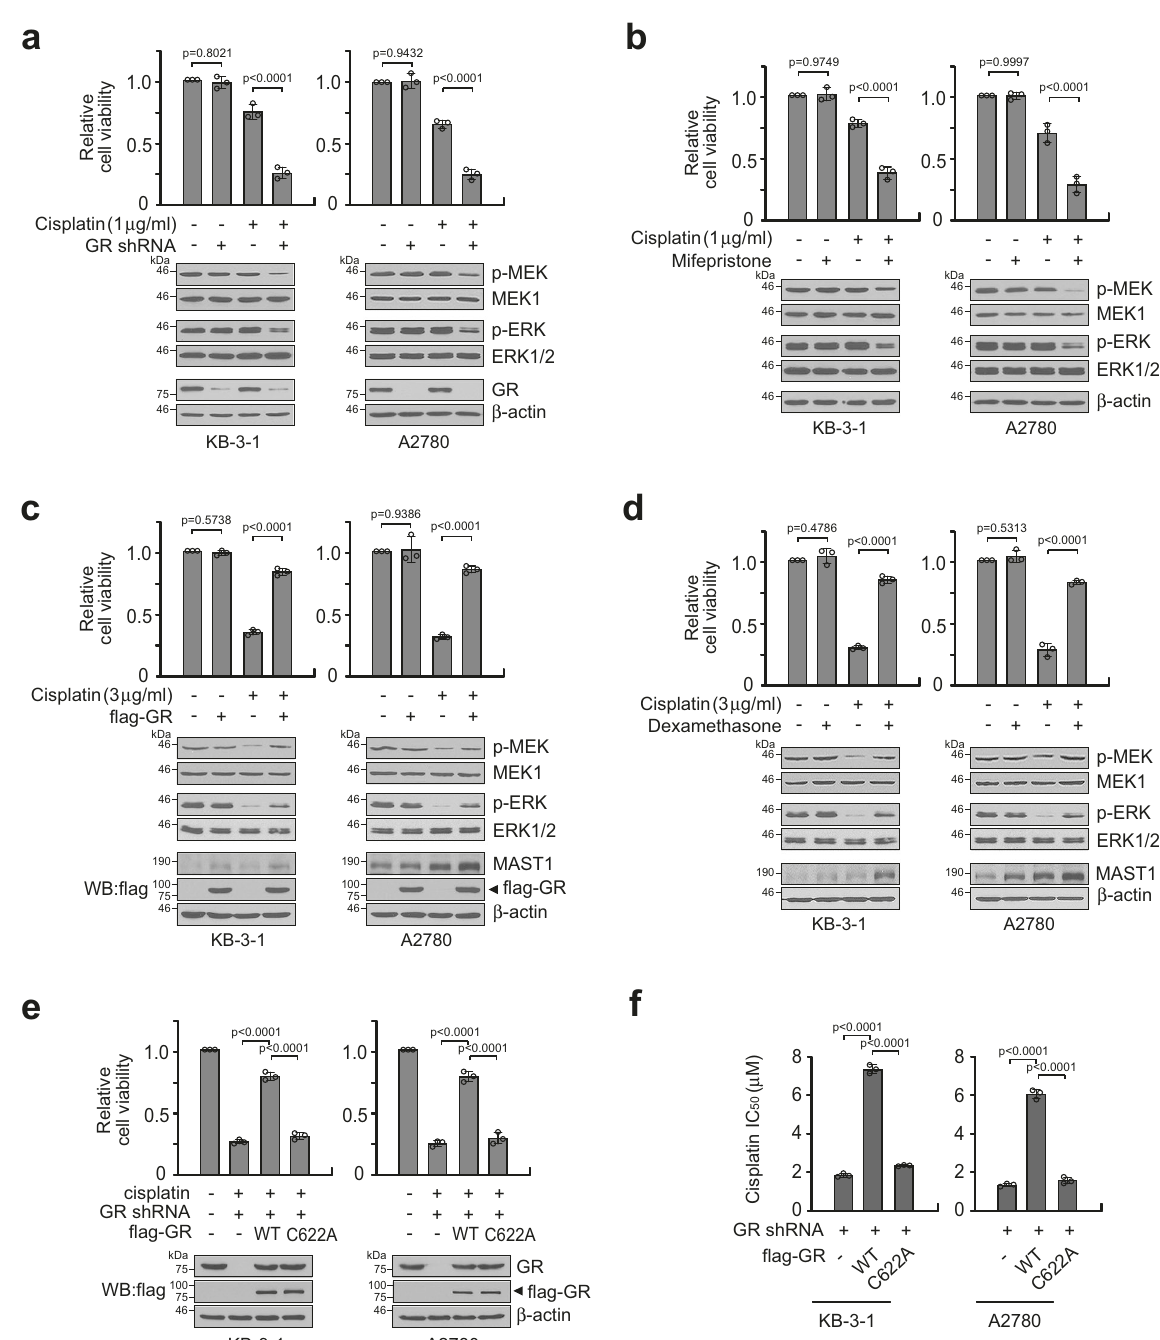
Fig. 5 GR C622 contributes to cisplatin resistance through MAST1. a , b Cell viability and MEK/ERK activity in GR target downregulated KB-3-1 and A2780 cells by GR shRNA ( a ) or mifepristone (10 μ M) ( b ) in the presence and absence of cisplatin. MEK and ERK activity was assessed by S221 MEK and T202/Y204 ERK phosphorylation. c , d Cell viability and MEK/ERK in GR enhanced KB-3-1 and A2780 cells by GR overexpression ( c ) or dexamethasone (500 nM) ( d ) in the presence and absence of cisplatin. e Cell viability of KB-3-1 and A2780 cells carrying GR WT or C622A in response to cisplatin. f Cisplatin IC 50 of KB-3-1 and A2780 cells harboring GR WT or C622A. Data are mean ± SD from three independent biological experiments. Error bars represent SD and statistical analyses were performed by one-way ANOVA. Source data are provided as a Source Data fi of MAST1 abolished cisplatin-resistant cancer cell proliferation, tumor growth, and MEK-ERK phosphorylation obtained by enforced GR expression or activation in vitro (Fig. 7f, g; Supplementary Fig. 6d, e) and in vivo (Fig. 7h – j; Supplementary Fig. 6f). In all, 2 mg/kg and 4 mg/kg of cisplatin was administered to adequately study the effect of GR-MAST1 modulation on cisplatin sensitization and resistance, respectively. These data